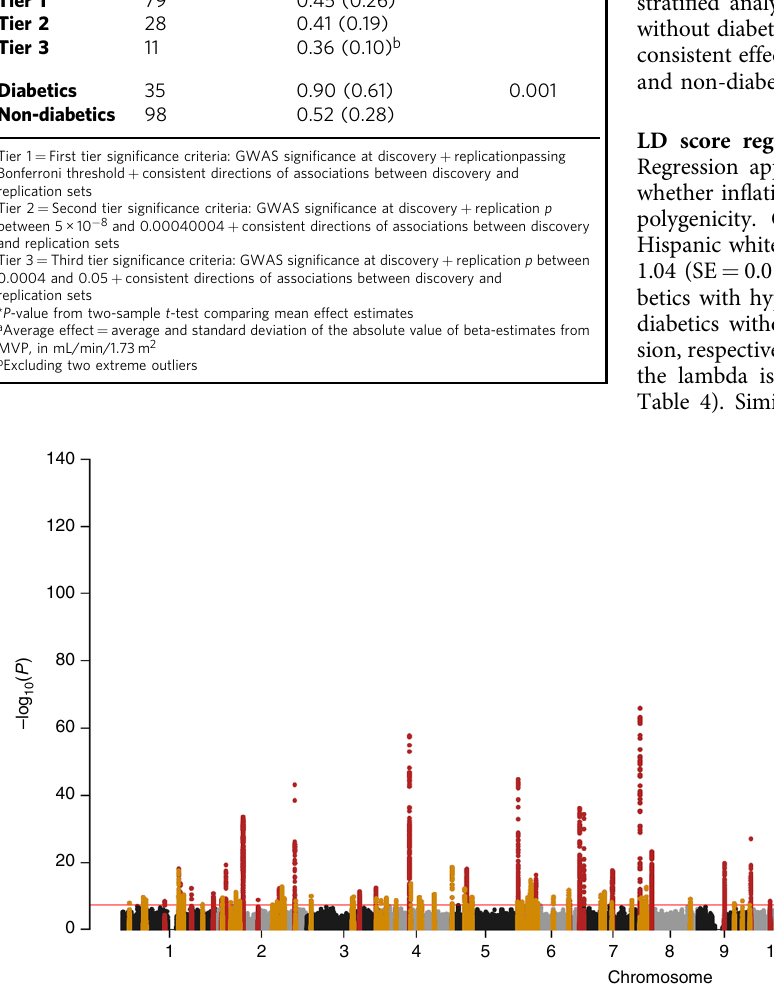
Fig. 1 Manhattan plot summarizing transethnic discovery meta-analysis of eGFR. The y axis shows the – log10 P -values and the x axis shows the chromosomal positions. The horizontal red line represents the thresholds of P -value = 5 × 10 − 8 for genome-wide signi fi cance. SNPs in red are in previously-identi fi ed kidney function loci, whereas SNPs in orange are in novel